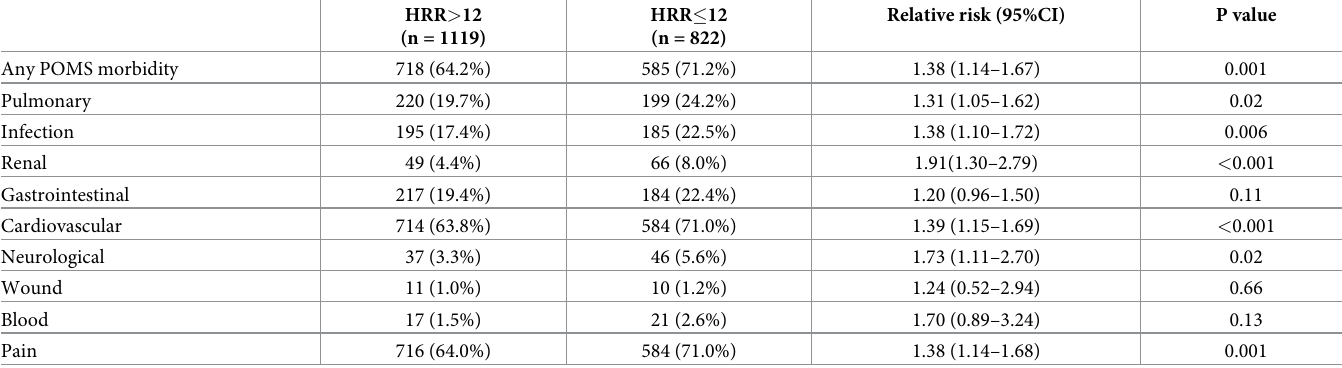
Table 2. Postoperative morbidity within 5 days of surgery. Data presented as n (%). % patients/HRR group provided within each surgical category. HRR- heart rate recovery.